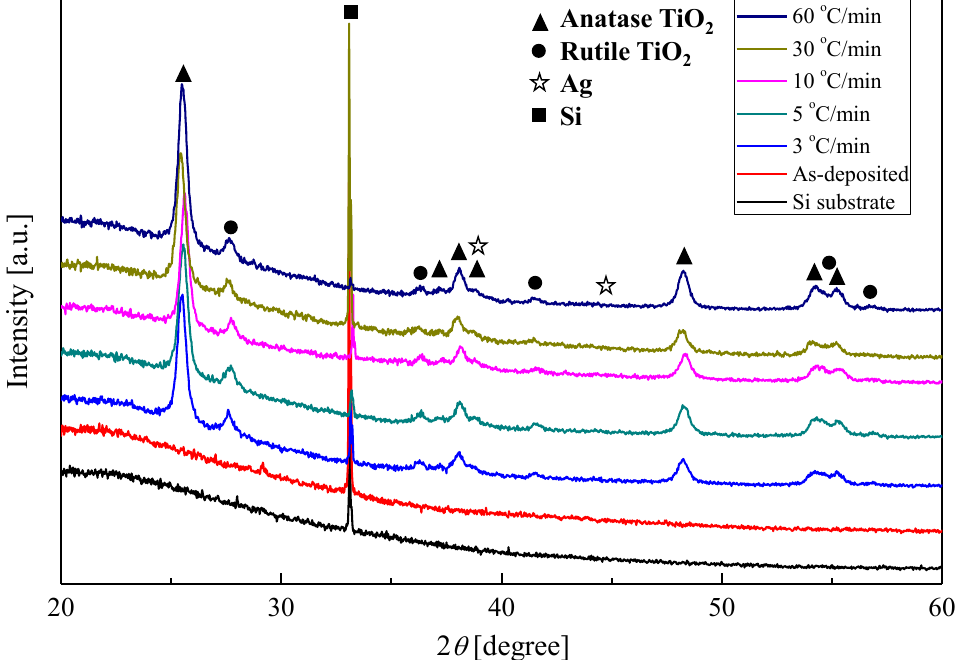
Figure 2. XRD patterns of TiO 2 –Ag nanocomposite films annealed at 600 ◦ C with heating rates of 3-60 o C/min including as-deposited.